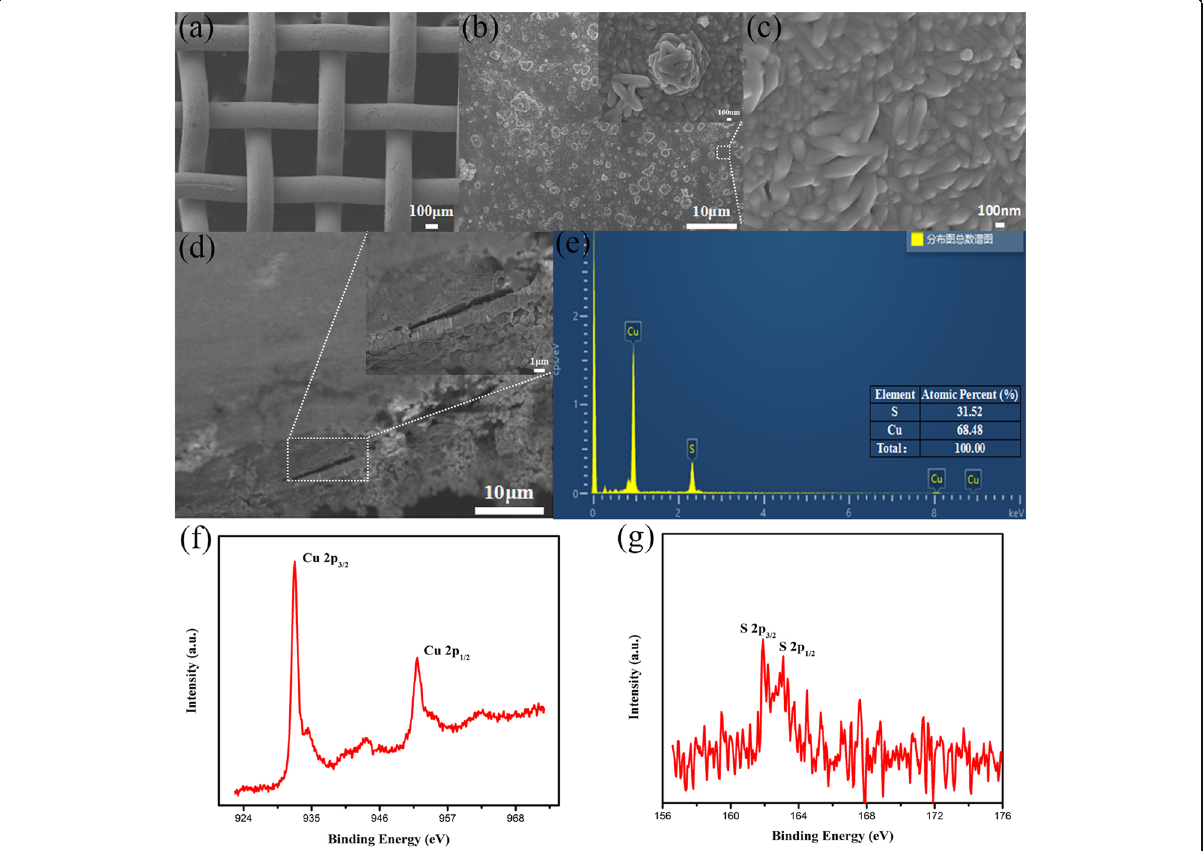
Fig. 2 SEM images of the mesh-structured Cu 2 S counter electrode: a top view; b , c enlarged view of surface morphology; d cross-sectional view and enlarged view of the Cu 2 S layer. e EDS of Cu 2 S. f , g XPS survey spectrums of Cu 2 S